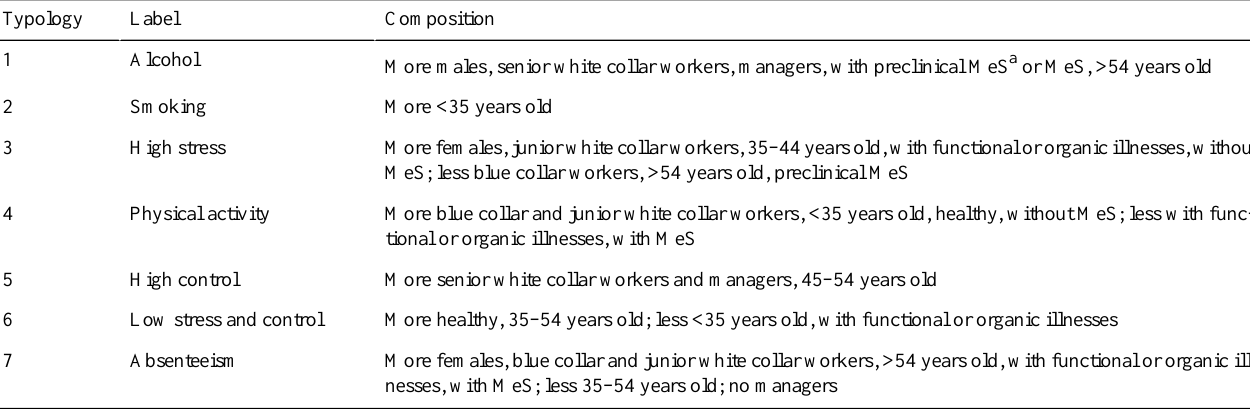
Table 6. Composition of subject typologies with respect to personal data, illnesses, and metabolic syndrome condition, and prevailing characteristics with respect to the distribution (more or less) of the considered characteristic in the survey population (descriptive analysis)